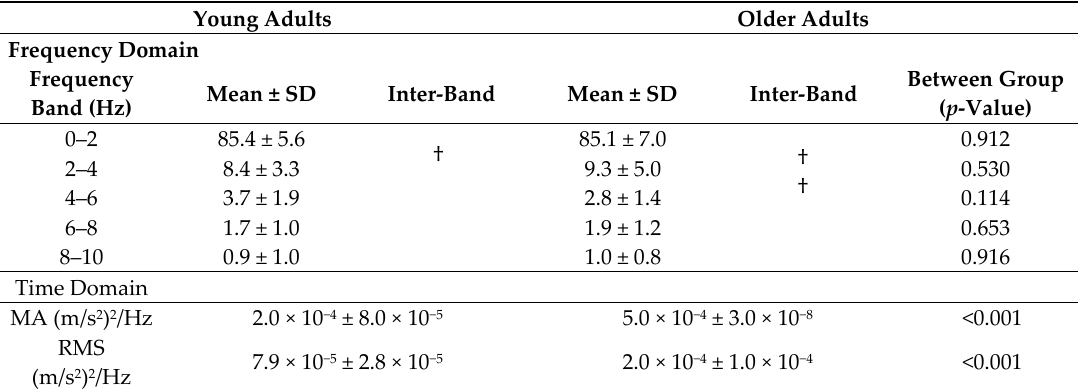
Table 2. Summary of anterior-posterior center of mass acceleration (apCOMacc), integrated power spectral density, maximum amplitude, root mean square for both age groups combined.